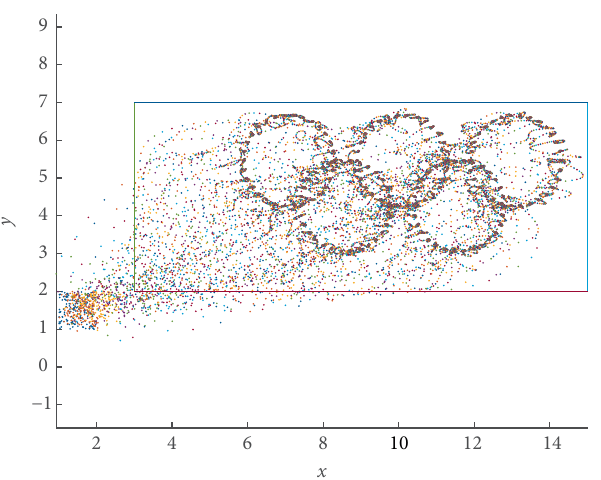
Figure 6: The control inputs 𝑢